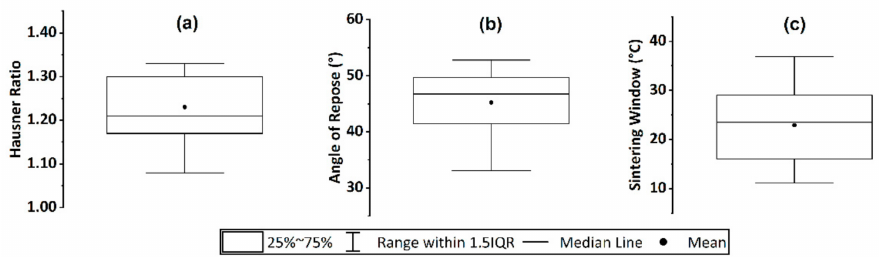
Figure 6. Statistics on flowability and sintering parameters of ( a ) Hausner Ratio and ( b ) angle of repose reported for flowability behavior, and ( c ) sintering window reported for thermal behavior of polymer powder